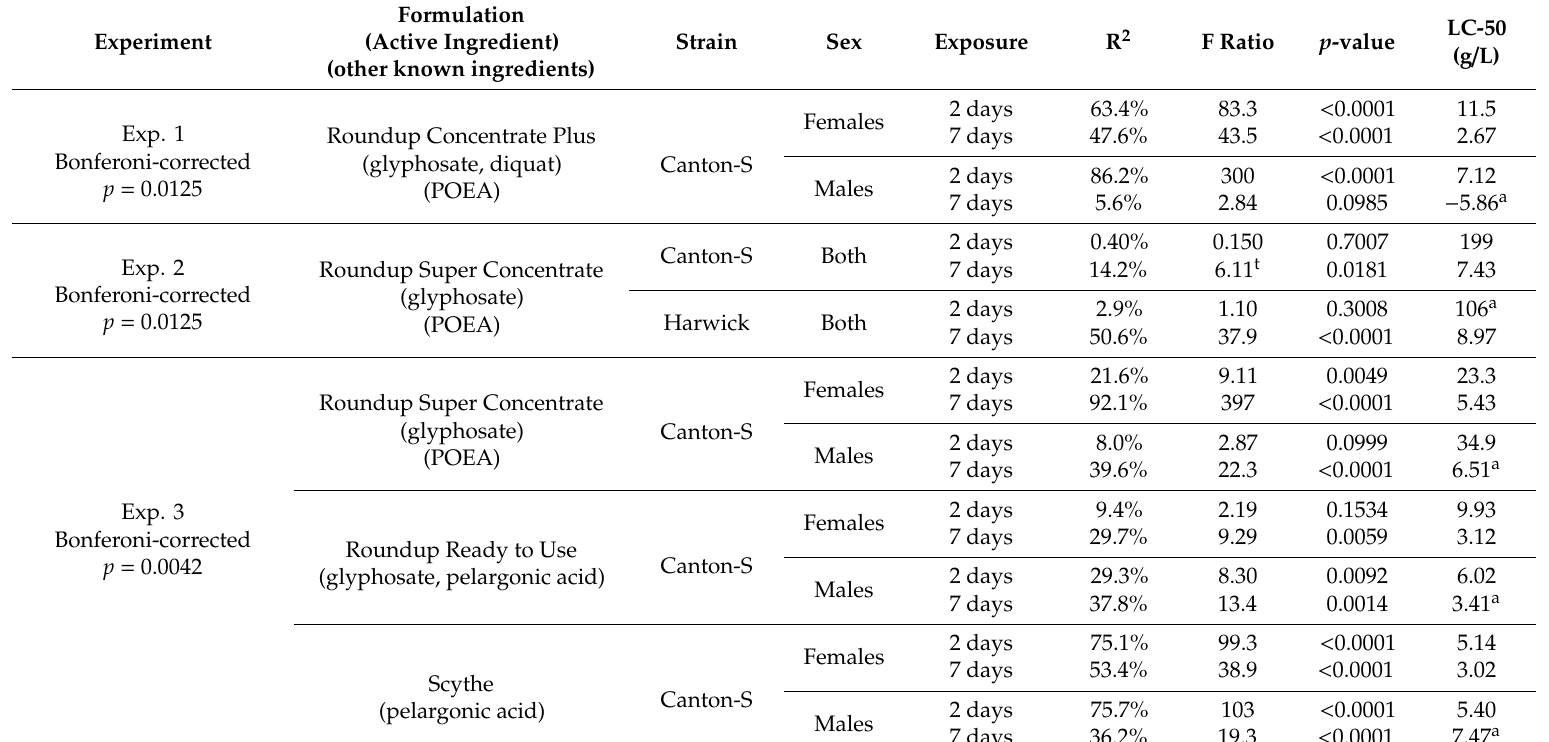
Table 2. Relative survival and herbicide concentration. Regression analysis of survival of D. melanogaster exposed to herbicide in their food medium, as a proportion of survival of flies exposed to organic control medium, on herbicide concentration for di ff erent durations of exposure, sexes, herbicide formulations, and wild-type strains of Drosophila . Significant p -values shown in bold. LC 50 is not meaningful if regression p is NS. a LC 50 is not meaningful because the mortality rate for controls was >